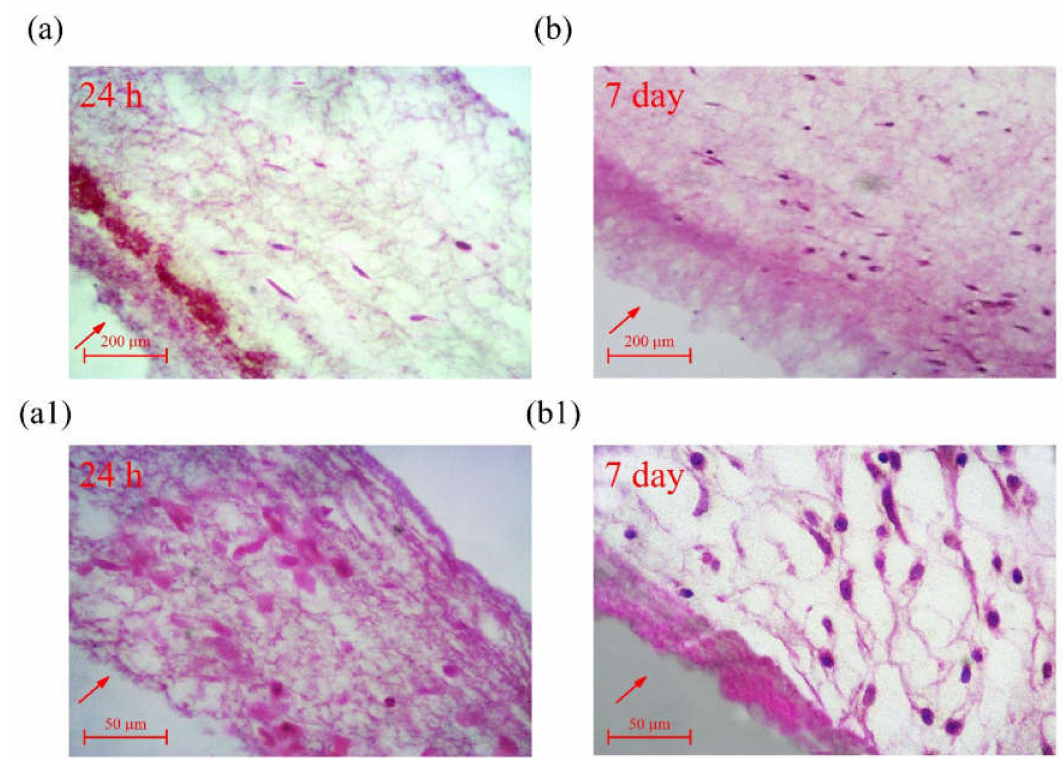
Figure 11. Evaluation of cell ingress into PCL fibrous mats using HDF cells: ( a , a1 ) after 24 h; ( b , b1 ) after 7 days (after simultaneous electrospinning of PVP and PCL, PVP fibers were removed to increase the porosity of electrospun samples).